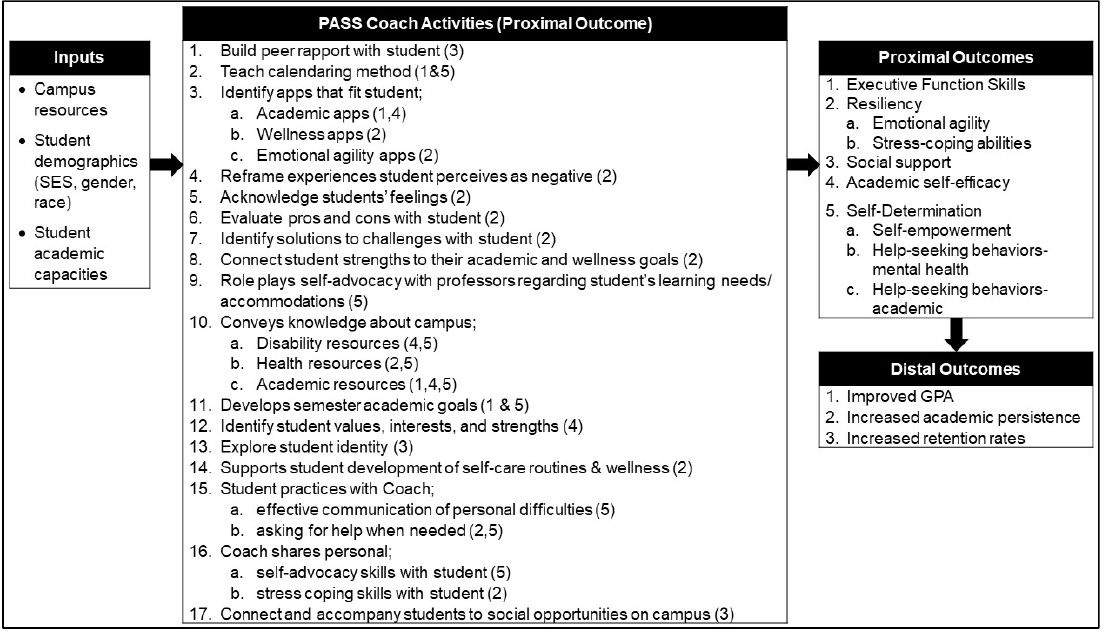
Figure 1. Logic model of the Peer Academic Supports for Success (PASS) coaching model.